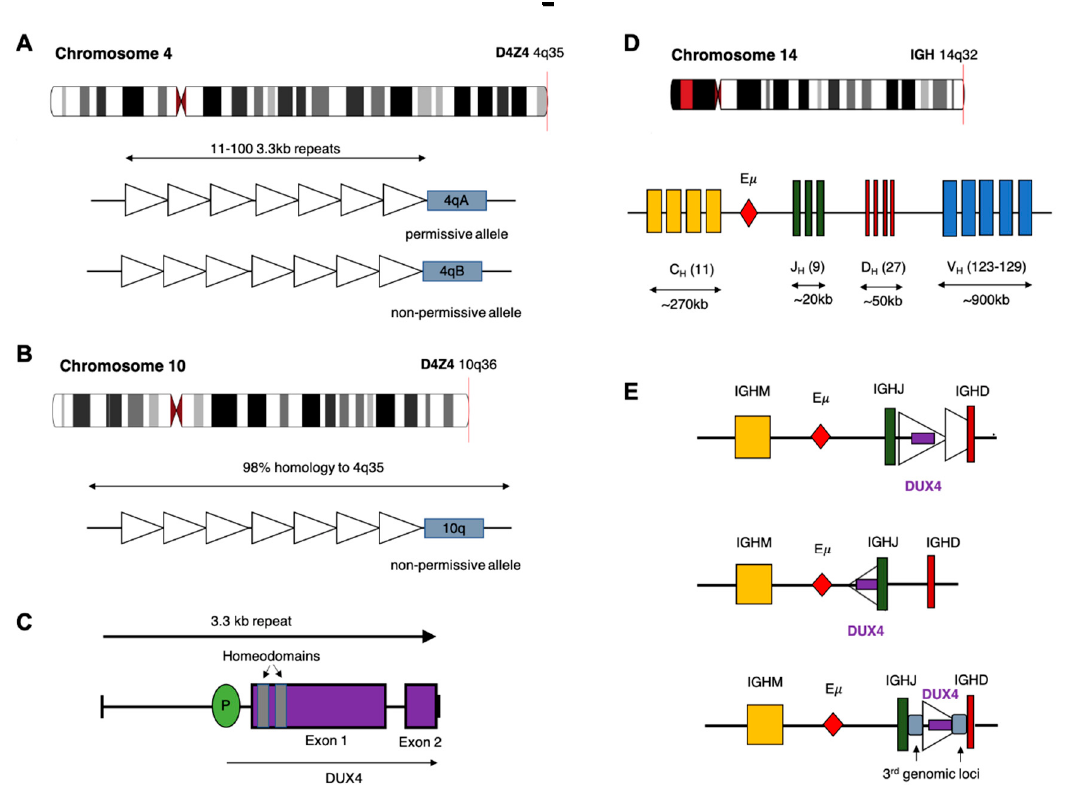
Figure 1. Potential chromosomal rearrangements involving IGH and DUX4 . ( A ) Ideogram of chromosome 4 indicating location of the D4Z4 array and a depiction of the two alleles which vary in the sequence distal to the final repeat (repeat indicated by open triangles). This includes the permissive 4qA allele which can result in FSHD when contracted to fewer than 10 repeats. ( B ) Ideogram of chromosome 10 indicating location of the homologous D4Z4 array with 98% identical sequence. This chromosome is associated with a non-permissive allele which does not result in FSHD. ( C ) Schematic diagram of the repeat 3.3 kb repeat sequence indicating location and exons of the DUX4 gene. ( D ) Ideogram of chromosome 14 and depiction of the IGH locus indicating constant (C H ), joining (J H ), diversity (D H ) and variable (V H ) alleles ( E ) Schematic diagram depicting possible rearrangements as a result of cryptic insertion of DUX4 from either chromosome 4 or 10 into the IGH locus. DUX4 can be inserted in either orientation, include only a partial or one complete and one partial copy of the repeat array and also be inserted with sequence from a third genomic location.